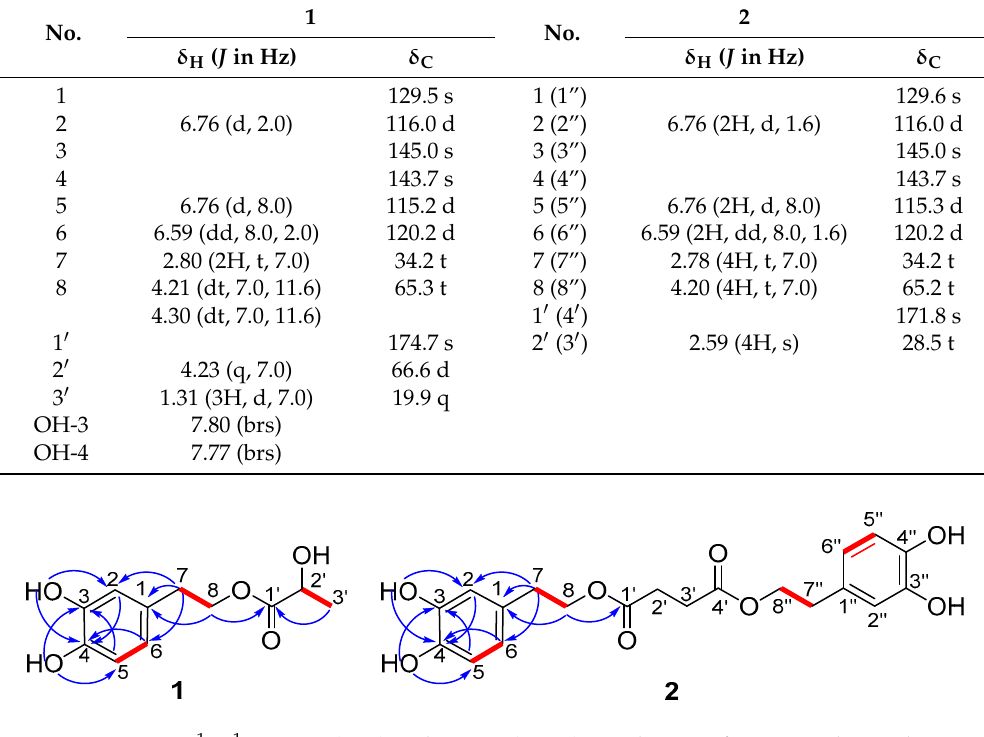
Figure 2. Key 1 H- 1 H COSY ( ) and HMBC ( ) correlations of compounds 1 and 2 .